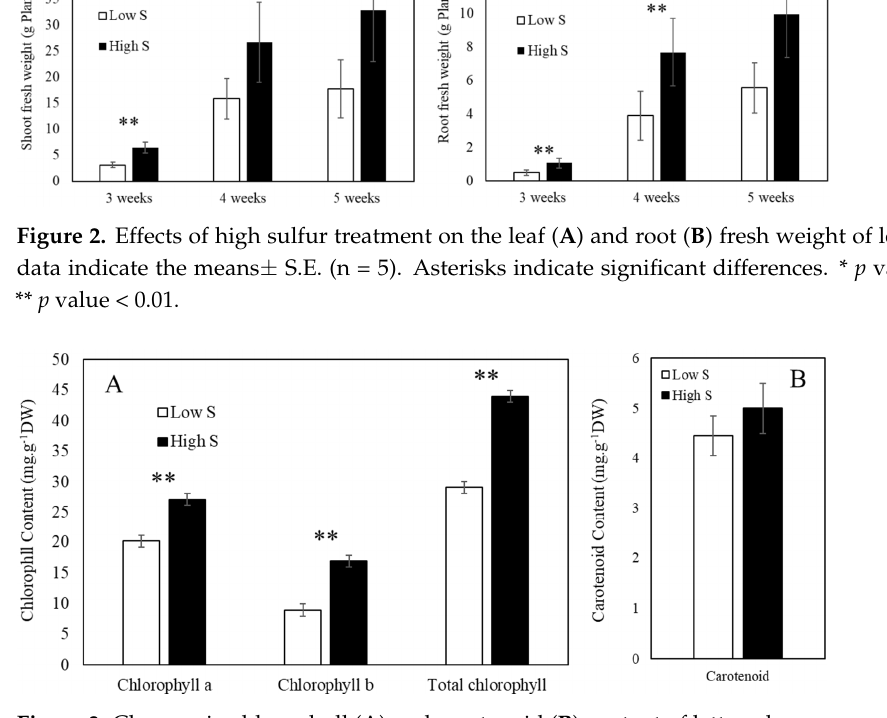
Figure 3. Changes in chlorophyll ( A ) and carotenoid ( B ) content of lettuce leaves were affected by low and high concentration of sulfur treatment in LED spray system for 4 weeks. The data indicate the means ± S.E. (n = 5). Asterisks indicate significant differences. ** p value < 0.01.